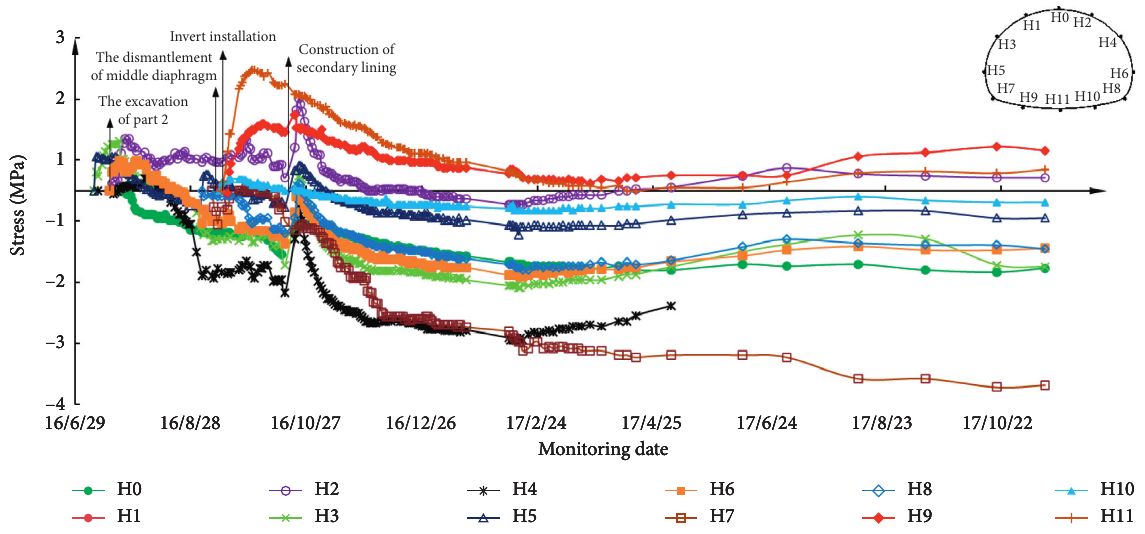
Figure 12: Stress temporal curve of shotcrete at YK2+133 section.